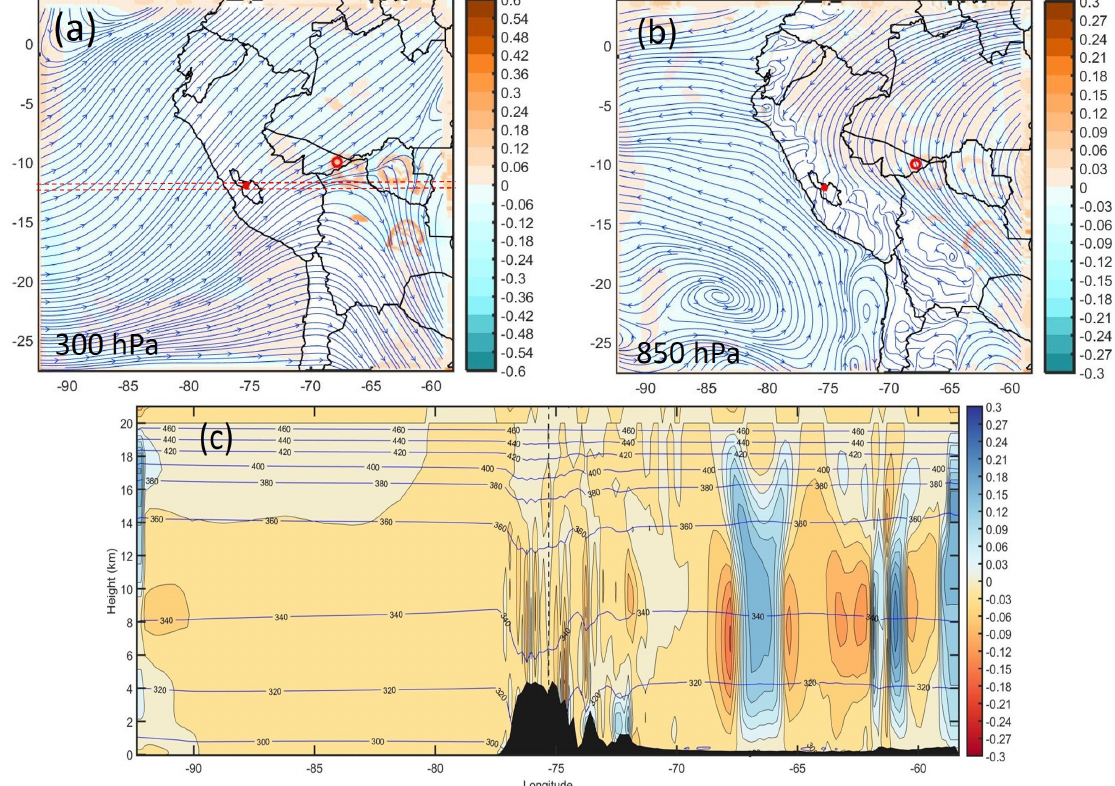
Figure 11. Composites of horizontal wind streamlines (m s − 1 ) and vertical wind speed (m s − 1 ) at ( a ) 300 hPa and ( b ) 850 hPa; ( c ) Vertical cross-section of mean vertical wind speed (m s − 1 ) along the longitude, between 11.98 ◦ S to 12.02 ◦ S. The composite data were obtained from the model WRF (resolution: 18 km) for the convective event TS1 at 15 UTC (10